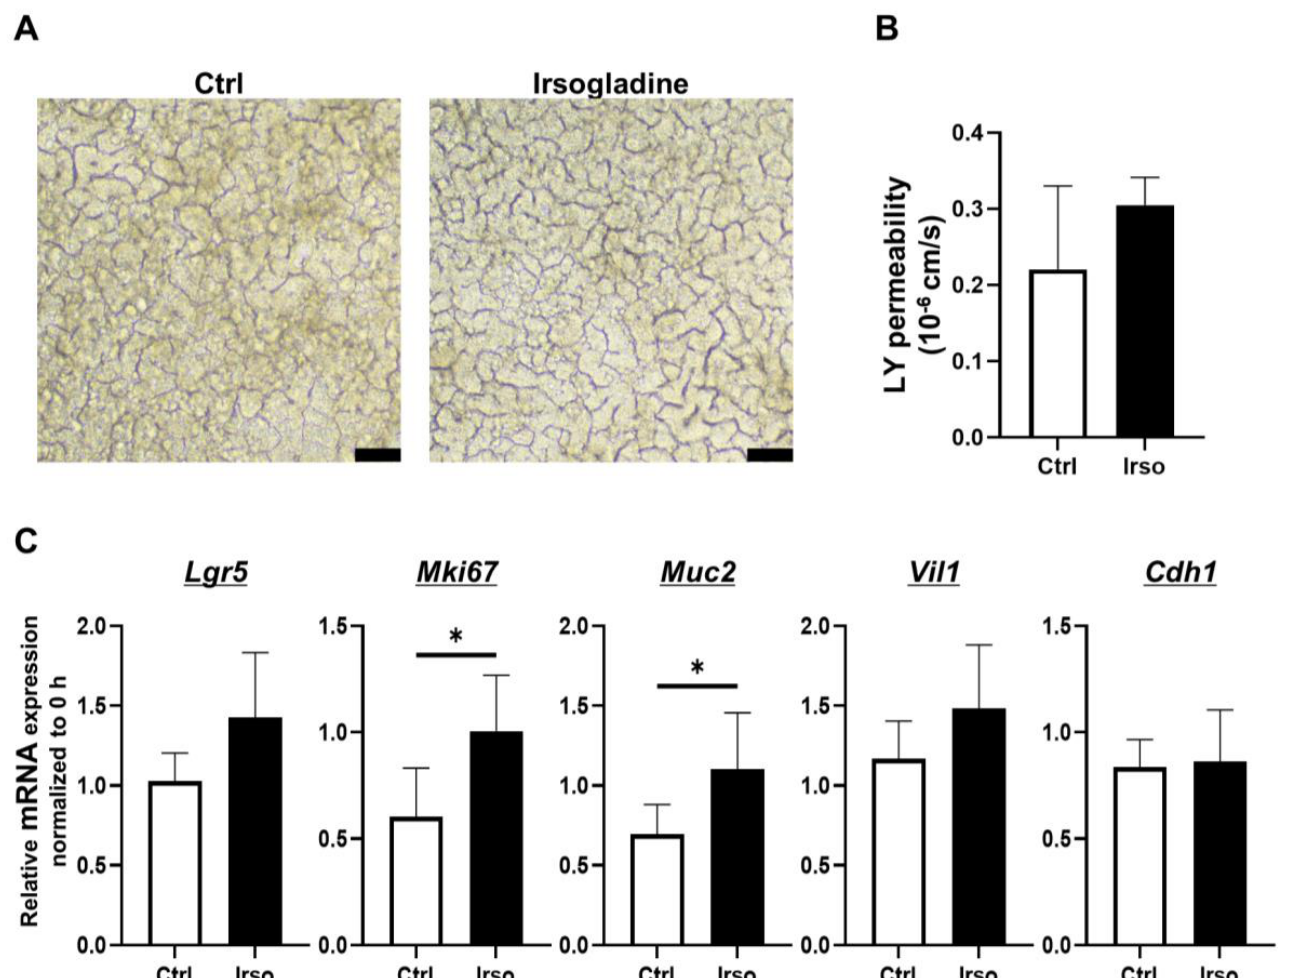
Figure 4. Effects of Irsogladine in 2D-hiPSC-SI under normal condition. Irsogladine was administered in culture medium for 48 h beginning on day 7. ( A ) Phase-contrast microscopy analysis on day 9. Scale bars, 100 µ m. ( B ) No significant difference in LY permeability was observed between the control and Irsogladine groups ( p = 0.4762); mean ± SD; n = 3. ( C ) Relative mRNA expression of Mki67 and Muc2 in 2D-hiPSC-SI cultured with Irsogladine for 48 h was significantly higher than that of the control group ( p < 0.05 each); mean ± SD; n = 3. Statistical analysis was performed using two-tailed Student’s t -test; * p < 0.05. Ctrl: control, LY: Lucifer yellow. Real-time quantitative RT-PCR analysis of cultured 2D-hiPSC-SI revealed that Irsogladine significantly increased Mki67 and Muc2 expression under both normal conditions (ASA 0 µ g/mL) and in the presence of 400 µ g/mL ASA ( p < 0.05 and p < 0.01; p < 0.05